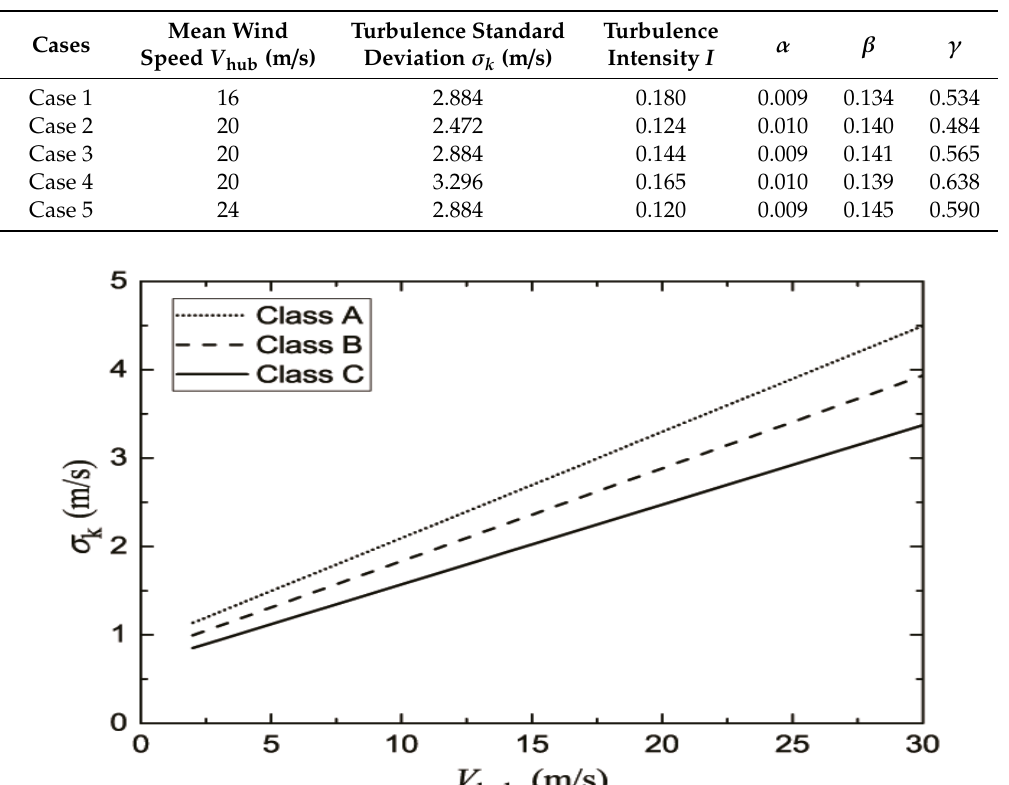
Figure 6. Turbulence standard deviation for the normal turbulence model (NTM) [12].